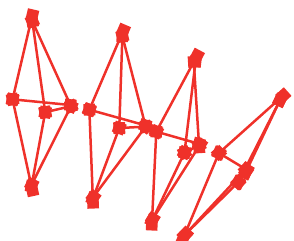
Figure 6: Interpolation example of the control grid.